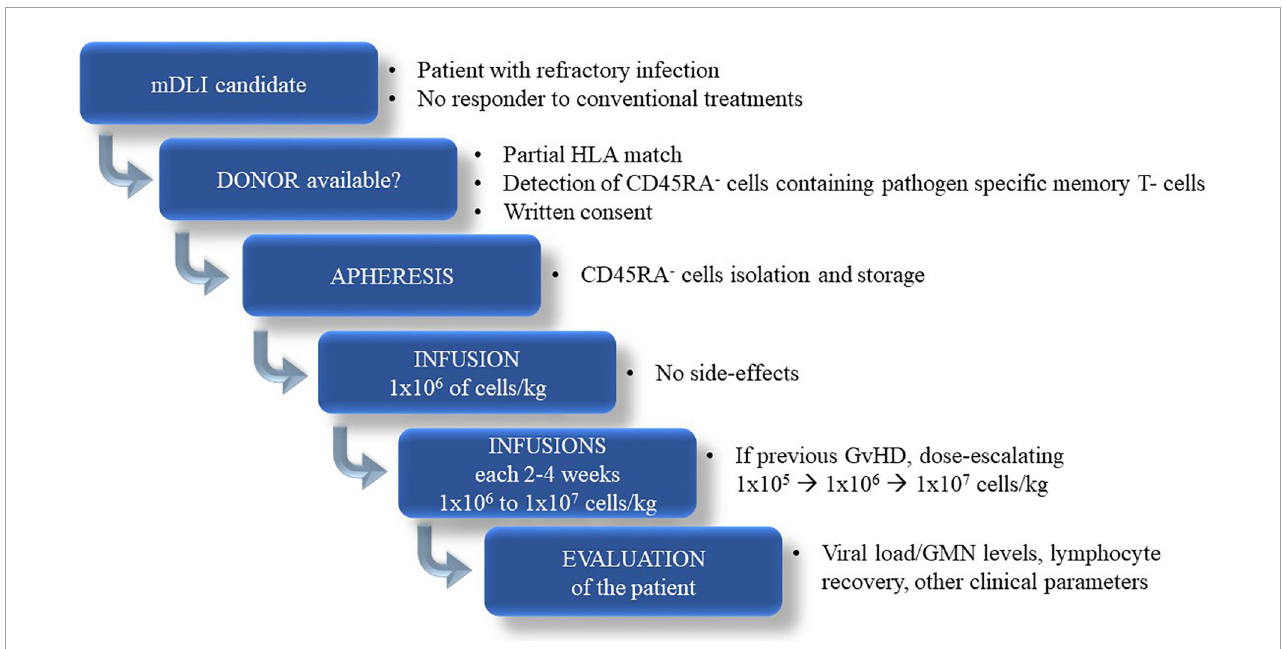
FIGURE1 Scheme describing the general procedure followed in our center to treat immunocomprimised patients with infectious diseases.